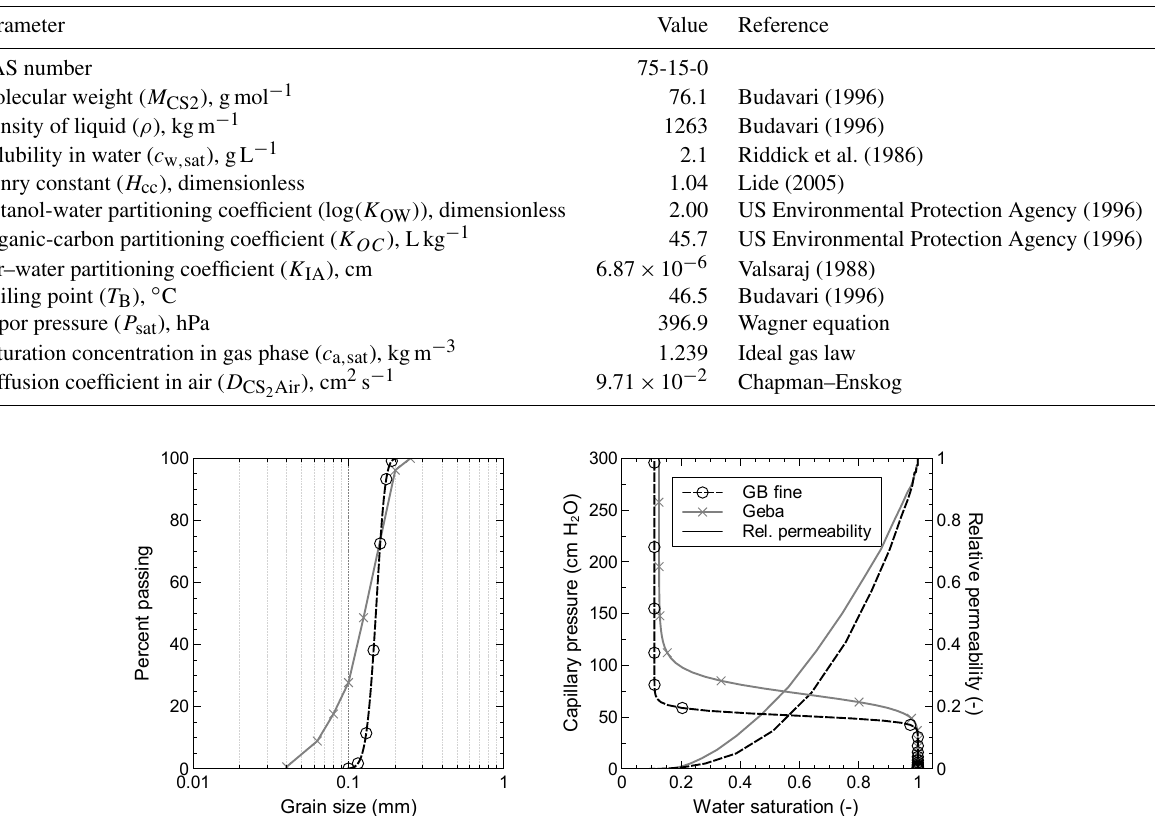
Table 2. Physicochemical properties of contaminant carbon disulfide (CS 2 ) at 20 ◦ C and 1013.15hPa. CAS indicates Chemical Abstracts Service.